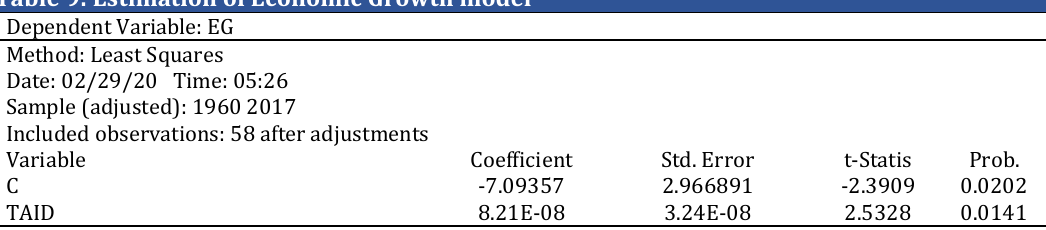
Table 9: Estimation of Economic Growth model